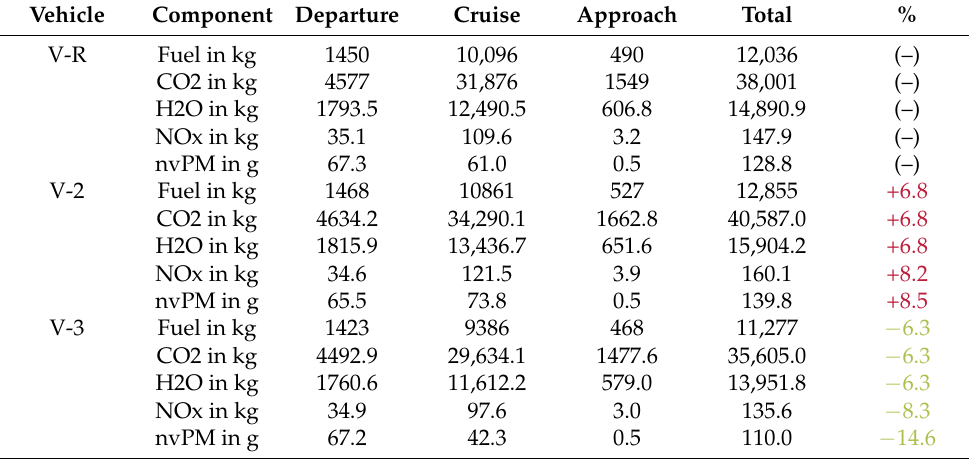
Table 5. Fuel consumption and emissions along the design mission ( ceo ). Advantageous change: green, disadvantageous change: red.